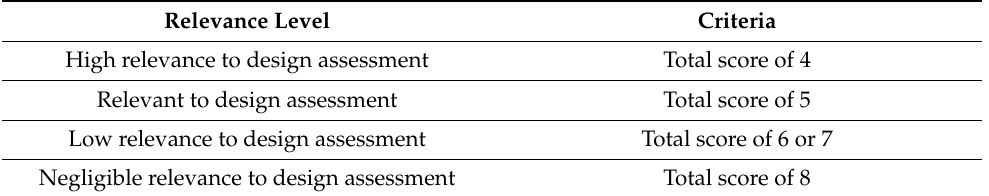
Table 2. Data relevance for manuscript inclusion/exclusion in the final reference